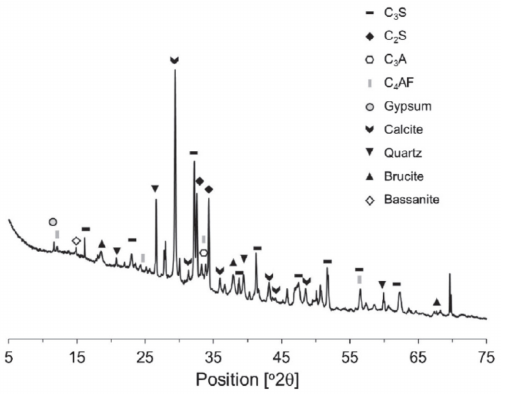
Figure 1. XRD pattern of CA. Reproduced with permission from [26]. Copyright 2018,